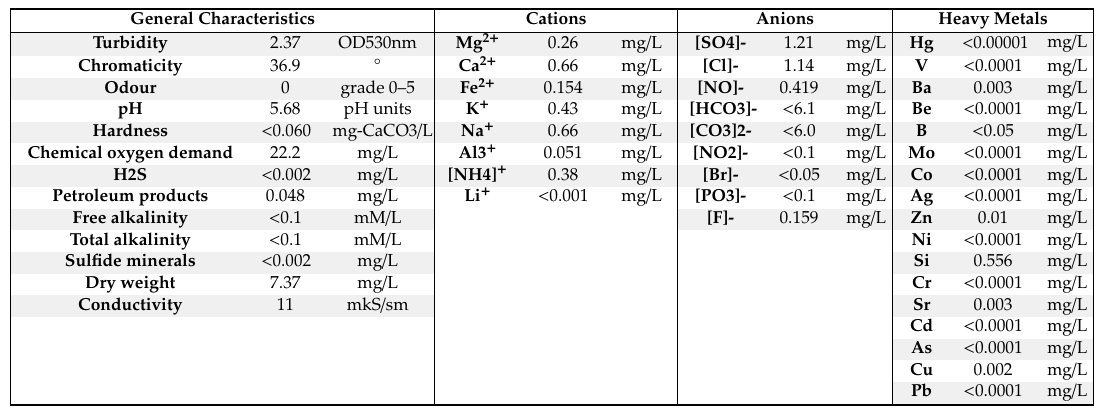
Table 1. Water quality